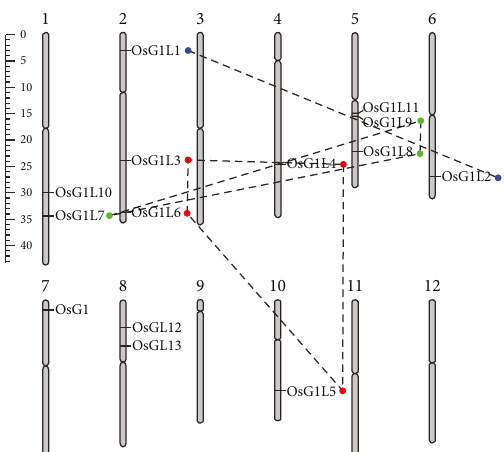
Figure 1: Genomic location and segmental genome duplication of the OsG1 / G1Ls . The chromosome numbers are indicated at the top of each chromosome, and the genes present on the duplicated chromosomal segments of the genome are connected by lines. The scale on the left is in megabases (MB). The segmental duplicated genes were elucidated from PGDD with a parameter of